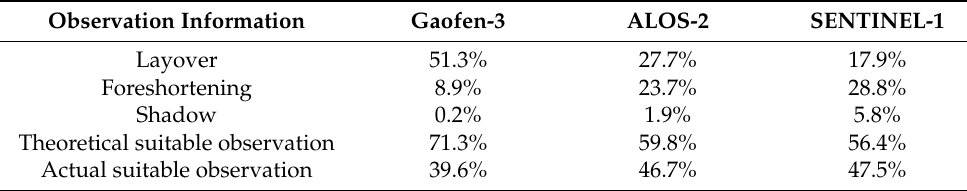
Figure 9. ( a ) Optical image of the study area. ( b ) Gaofen-3 ’s geometric distortion of the study area. ( c ) ALOS-2 ’s geometric distortion of the study area. ( d ) SENTINEL-1 ’s geometric distortion of the study area. Table 5. Comparison of the SAR data ’s observation information.